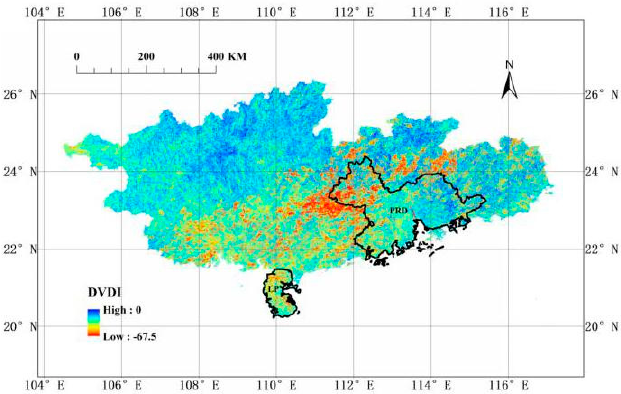
Figure 5. The spatial distribution of accumulated DVDIs of 28 selected typhoons from 2000 to 2018.